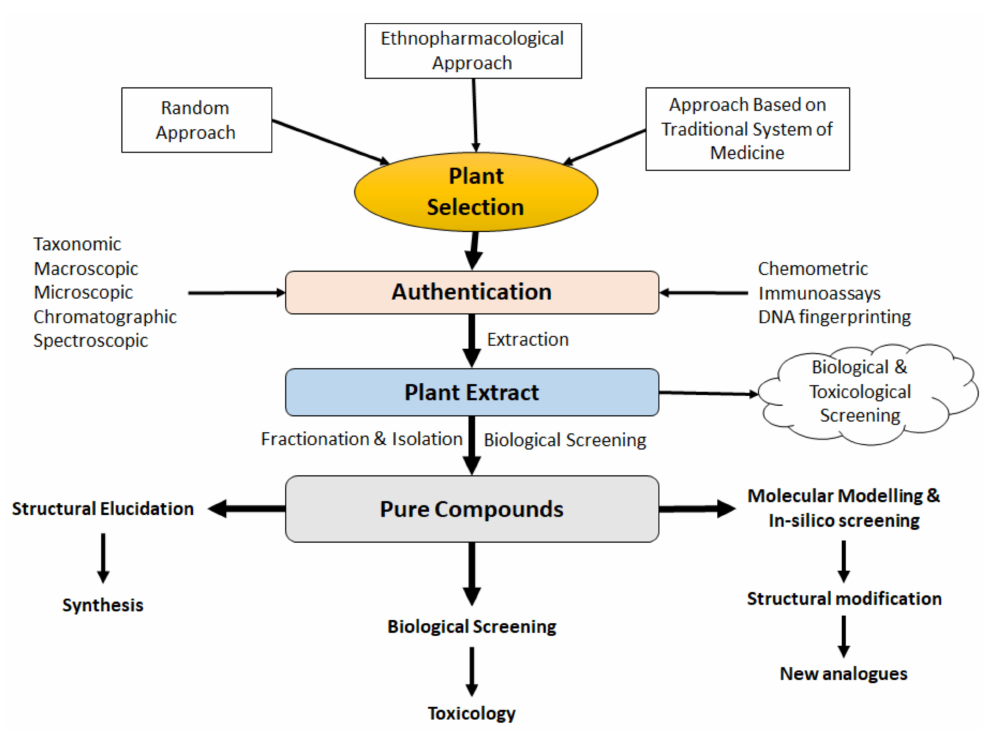
Figure 5. The overall approaches in modern drug discovery and development process from botanical